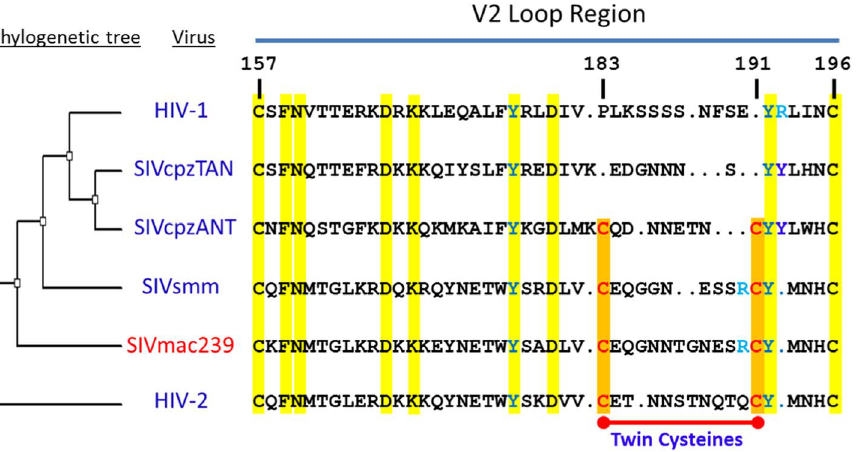
Figure 1. Phylogeny of the gp120 V2 region in PLVs. The Phylogenetic tree (unrooted, left panel) was constructed based on whole genome nucleotide sequences, using a neighbor-joining method [43] and bootstrapping for 1000 steps. The associated gp120 V2 region sequence alignment was accomplished using the Clustal W program [44]. The twin-cysteine residues are colored red and marked with a red bar, and the conserved tyrosine (Y) in green. The residues are numbered based on the standard system, which uses HXBc2 as a reference [45]. The viral strains used for the phylogenetic tree construction are as follows respectively: HIV-1, AF033819; HIV-2, M30502; SIVcpzANT, U42720; SIVcpzTAN, EF394356; SIVsmm,